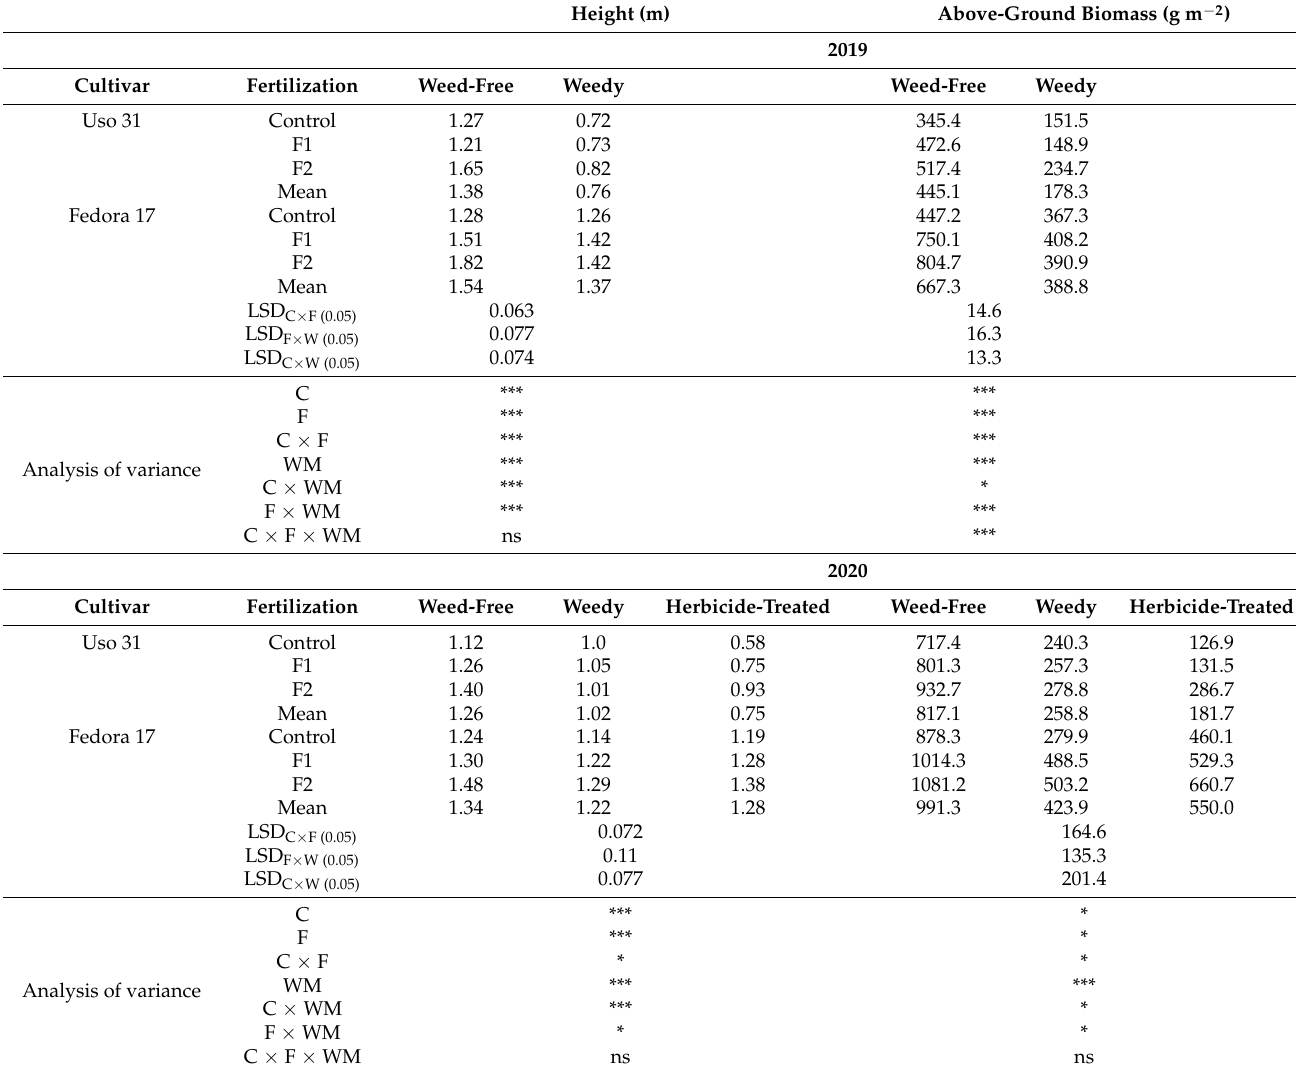
Table 1. The effects of the experimental factors on the average values and the analysis of the height and above-ground biomass of hemp crop across the two growing seasons, 2019 and 2020. WM: weed management treatments (WF: weed-free; W: weedy; HT: herbicide-treated); C: cultivars; F: fertilization treatments (Control: without fertilization; F1: 70 kg ha − 1 ; F2: 140 kg ha − 1 ). Height